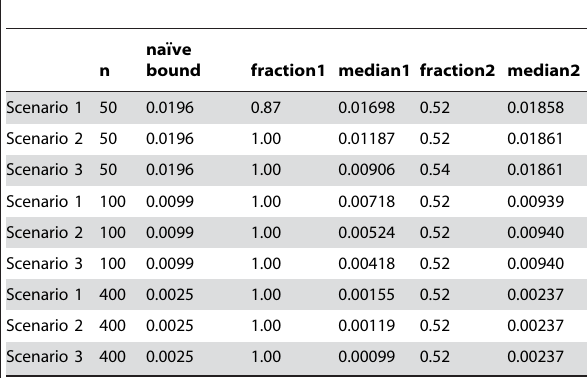
Table 4. Summary of the results of the simulation part of Example 5.